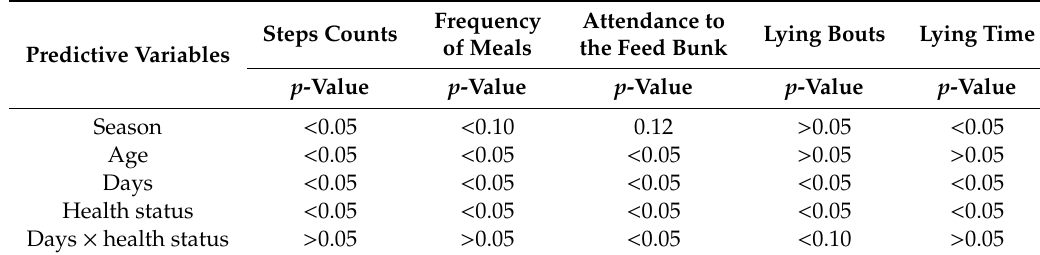
Table 1. The probability level for the e ff ect of health status, days before sickness, season, and the interaction between health status and days of sickness on the daily steps counts (n / day), frequency of meals at the feed bunk (n / day), attendance at the feed bunk (min / day), number of lying bouts (n / day), and lying time (min / day) for sick bulls (n = 71) vs . matched paired healthy control bulls (n = 213).